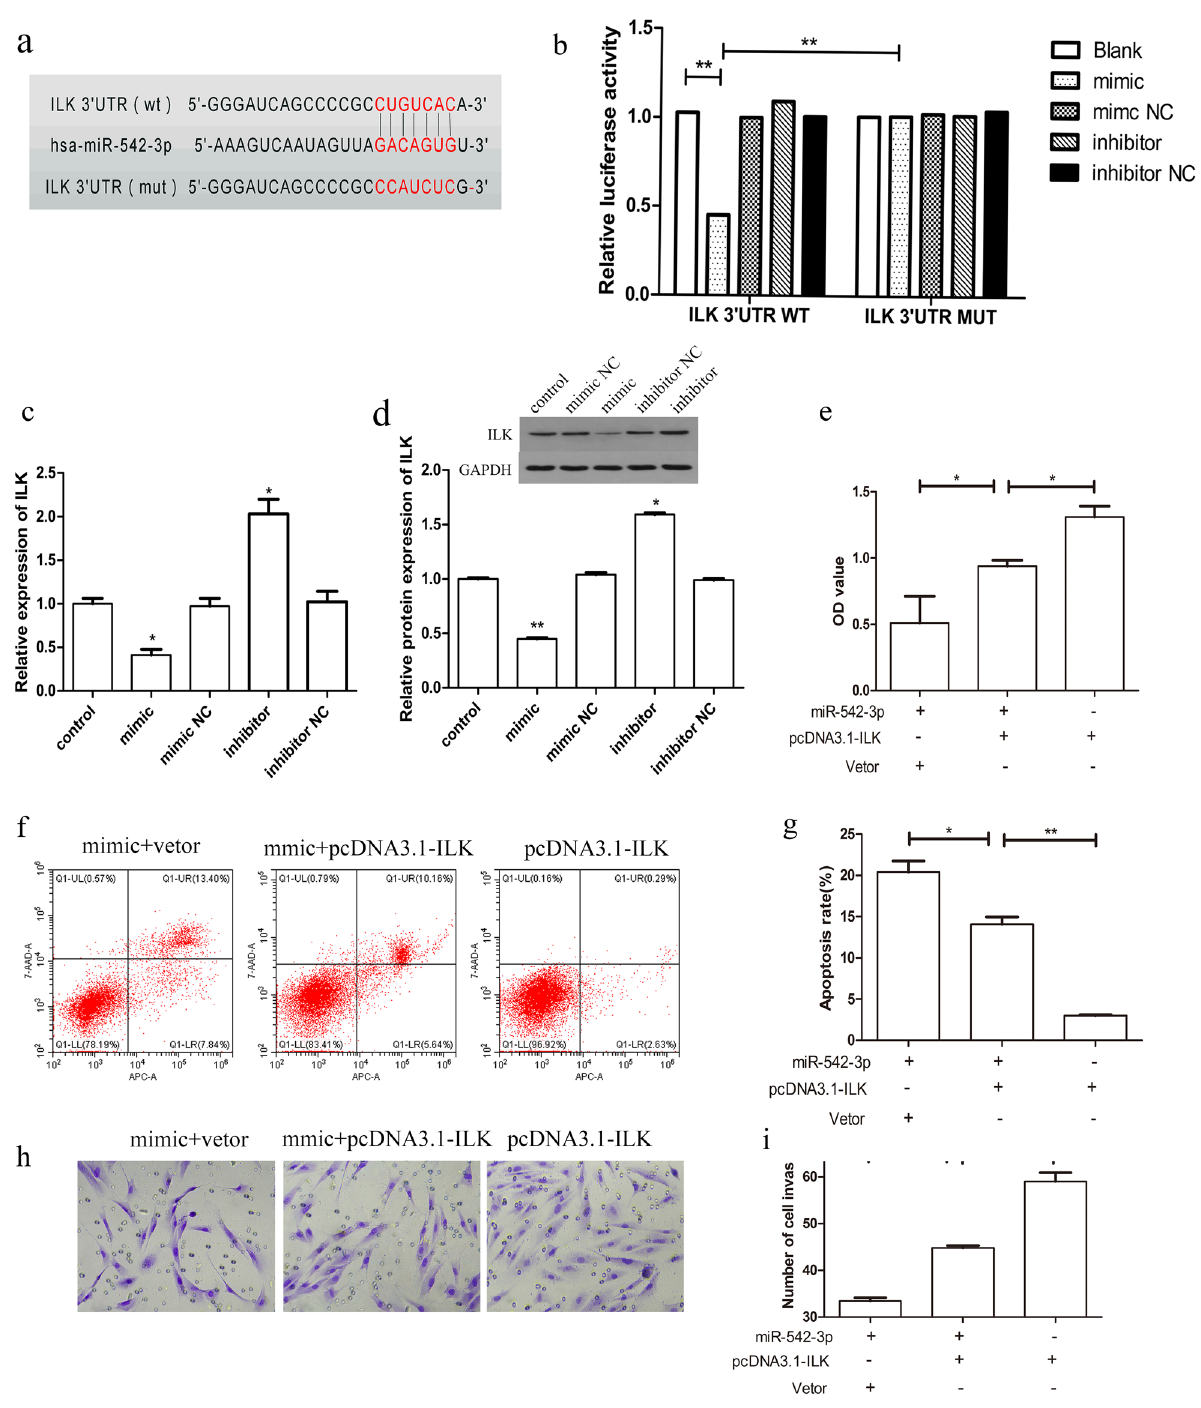
Figure 3. The confirmation of the miR-542-3p target ILK and effect of ILK-overexpression on cell Proliferation, invasion and apoptosis. ( a ) The predicted target sequence of miR-542-3p in the 3 ′ -UTR of ILK and the mutated sequence are shown. ( b ) Relative luciferase activity of ILK-wt and ILK-mut reporter vectors co-transfected with miR-542-3p mimic or mimics NC or inhibitor or inhibitor NC miRNA in decidualized HESCs. Luciferase activity was measured and normalized by Renilla luciferase activity after 48 h. ( c , d ) q-PCR and western blotting analyzed the ILK expression in control or miR-542-3p mimic or mimics NC or inhibitor or inhibitor NC groups. ( e ) MTT assay analysis of HESCs proliferation after co-transfected with pcDNA3.1-ILK vector, together with/ without miR-542-3p mimic. ( f , g ) Analysis of percent apoptosis of HESC cells by Flow cytometric analysis after co-transfected with pcDNA3.1-ILK vector, together with/without miR-542-3p mimic. ( h , i ) Representative images (200X) of Transwell assay showing invasion ability of HESC after co- transfected with pcDNA3.1-ILK vector, together with/without miR-542-3p mimic. Significance is marked as *p < 0.05, **p < 0.01.Values are expressed as mean ± SD of three independent